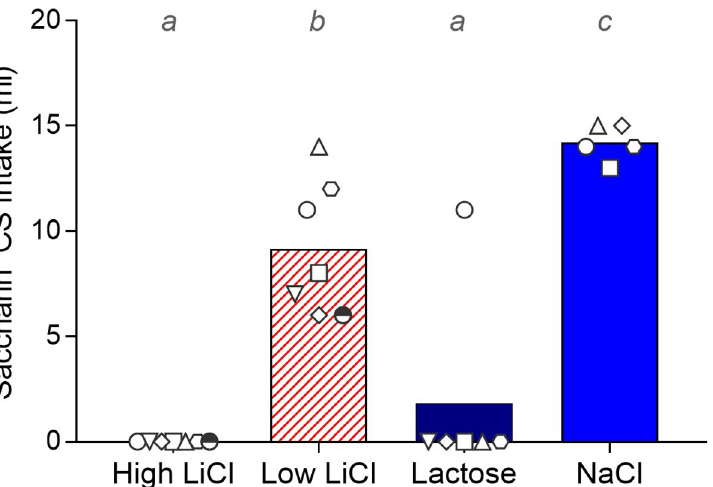
Fig 2. Filled histograms show mean total intake of the saccharin CS on the single-bottle test for each training group in Experiment 1a after taste-ID conditioning, with the total intake of each individual rat within each training group indicated by the white symbols. A given rat in each training group is represented by the same symbol across all Experiment 1a figures. Histograms with different gray letters were found to be significantly different from one another with post hoc t-tests, Bonferroni-corrected for multiple